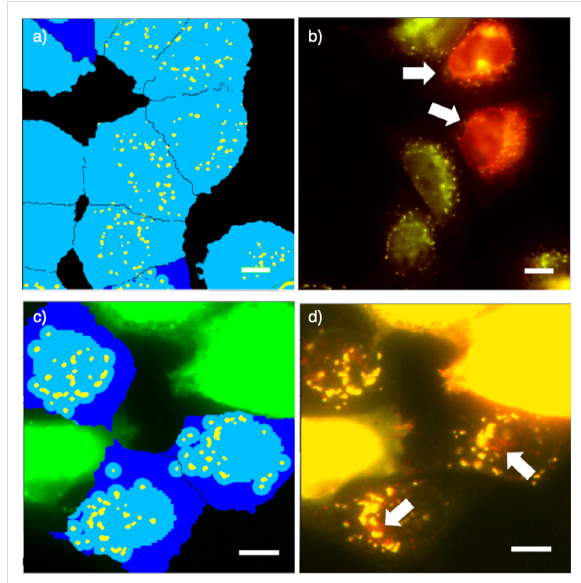
Figure 10: Examples of automated HC imaging of transiently trans- fected HeLa cells with HaloTag–GFP on Golgi, labeled with 26 . a) GFP channel showing the applied cell-body mask (light blue), Golgi mask (yellow), and the mask of the cell regions with low or no GFP signal (dark blue) in all cells. b) Same image as in a) with an overlay (yellow) of the GFP (green) and 26 (red) channels, showing off-target fluores- cence from 26 in some cells (white arrows). c) GFP channel after the selection of the cells with an adequate level of expression of the fusion protein. The applied masks for the cell body (light blue), the Golgi (yellow), and the cell regions with low or no GFP signal (dark blue) are shown only in the selected cells. Over-transfected cells (without dark blue regions) are not masked and excluded from the analysis. A very intense GFP signal (green) can be seen in the excluded cells. d) The same image as in c) with an overlay (yellow) of the GFP (green) and 26 (red) channels, showing off-target punctate fluorescence from 26 in some specific locations inside the selected cells (white arrows). Scale bar: 10